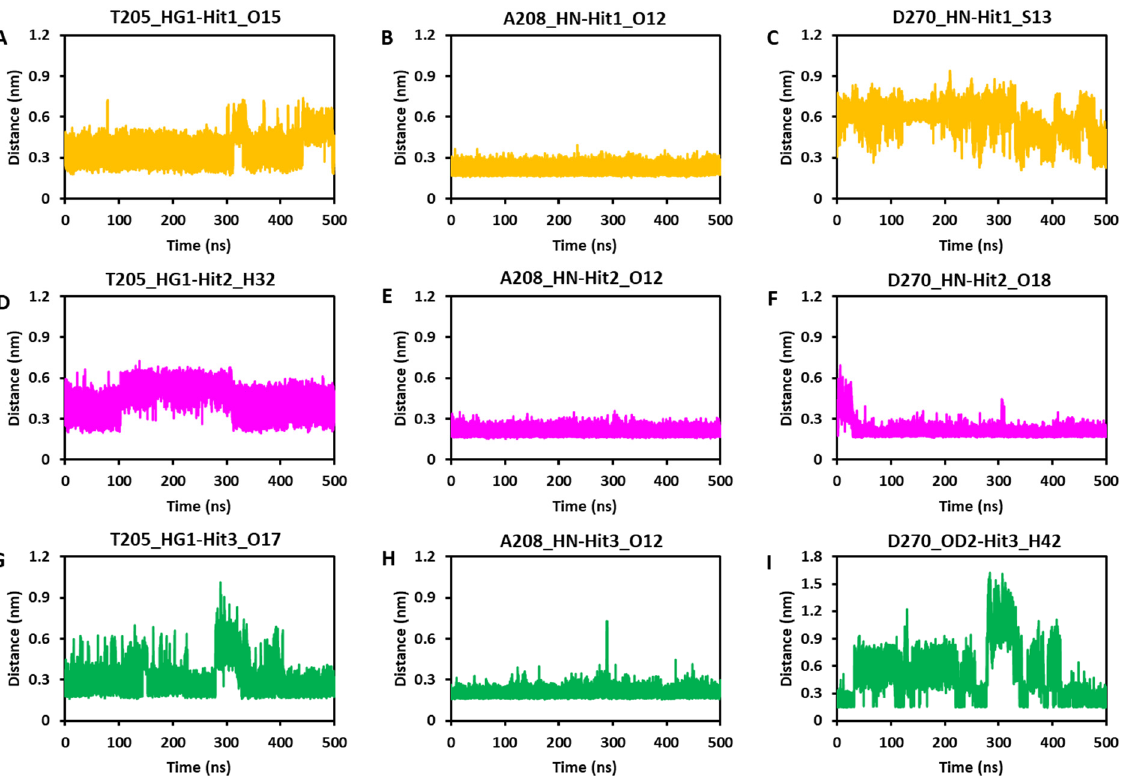
Figure 9. Analyses of Hydrogen bond dynamics. The distance was measured between the ACK1 key residues T205, A208, and D270 with Hit1 ( A – C ), Hit2 ( D – F ), and Hit3 ( G – I ).